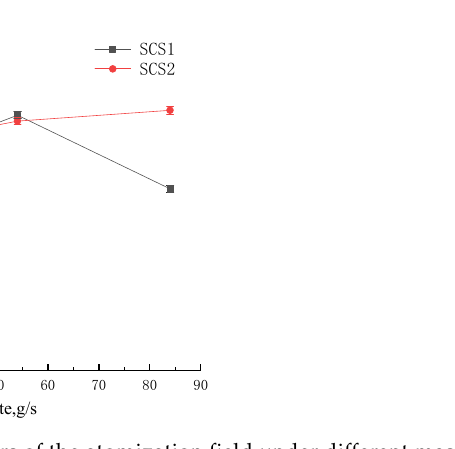
Figure 7. Sauter means diameters of the atomization field under different mass flow rates by PDPA.